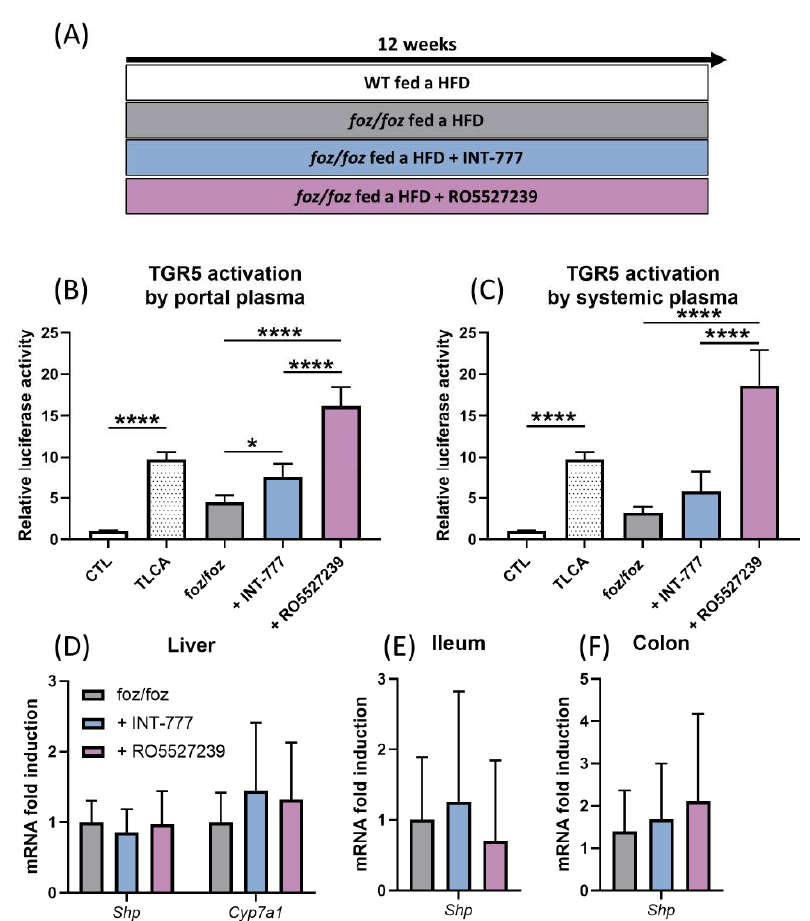
Figure 4. INT-777 and RO5527239 stimulate TGR5 signaling with no effect on FXR signaling. ( A ) Foz/foz mice were fed for 12 weeks an HFD supplemented with INT-777 or with RO5527239; then, they were compared to foz/foz and WT mice fed an HFD for 12 weeks. ( B , C ) TGR5 activation by the portal or systemic plasma of WT, foz/foz , foz/foz + INT-777 or foz/foz + RO5527239 mice in the cell reporter assay. CTL represents the basal activation and TLCA represents the activation induced by tauro-lithocholic acid, which was used as a positive control. ( D – F ) Expression of FXR target genes in the liver, ileum and colon of WT, foz/foz , foz/foz + INT-777 and foz/foz + RO5527239 mice (n = 7/group). Mean ± SD. One-way ANOVA followed by post hoc Bonferroni correction. Statistical significance is represented by * p < 0.05 and **** p < 0.0001. All p -values < 0.05 are represented on the graphs, while p -values > 0.05 are not.